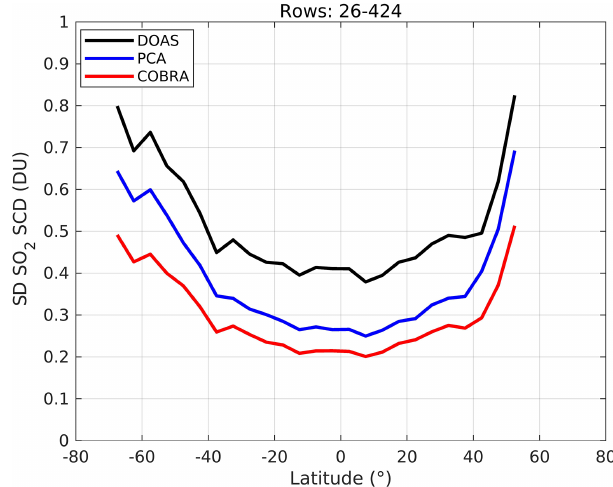
Figure 3. Standard deviation of the SO 2 slant columns as re- trieved from DOAS (black), PCA (blue) and COBRA (red) for one TROPOMI orbit (10394 on 15 October 2019, same as Fig. 1) for rows 26–424, as a function of latitude (for 5 ◦